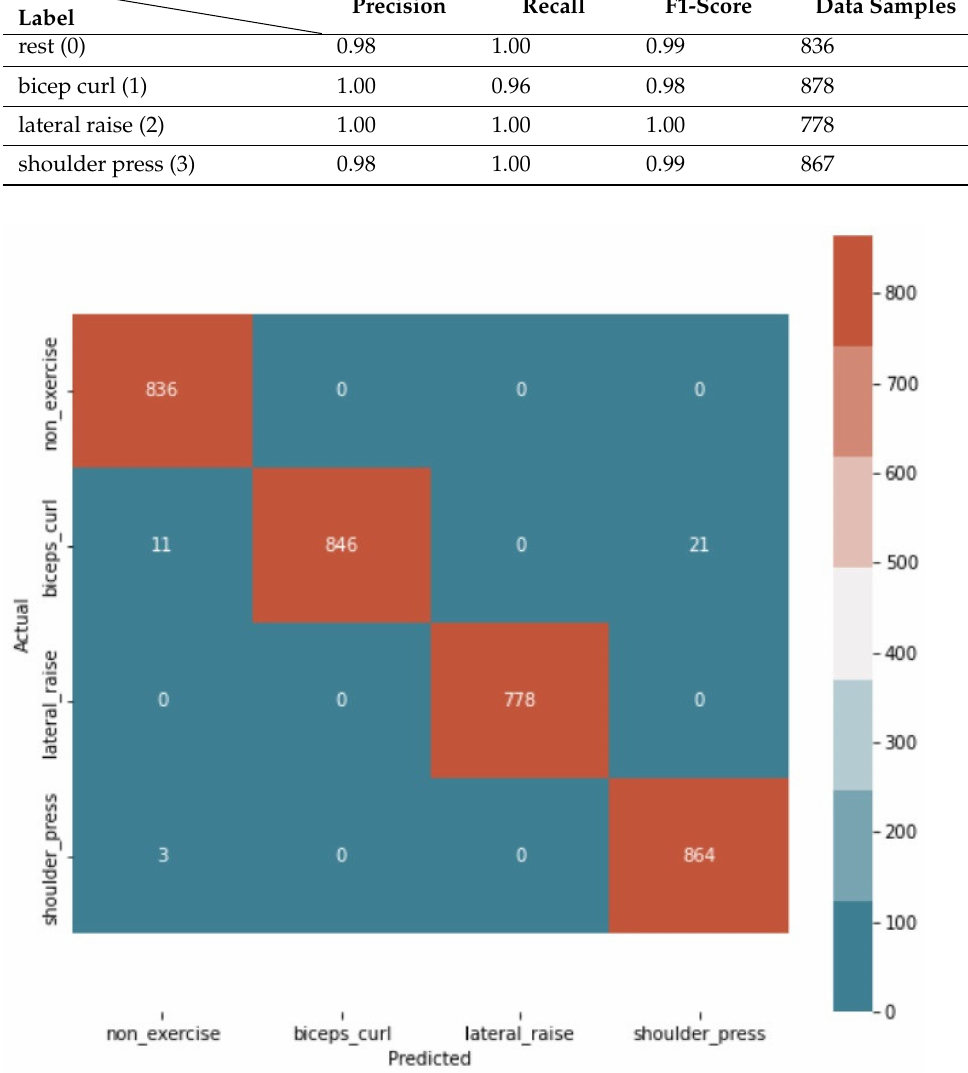
Figure 12. Confusion matrix of test